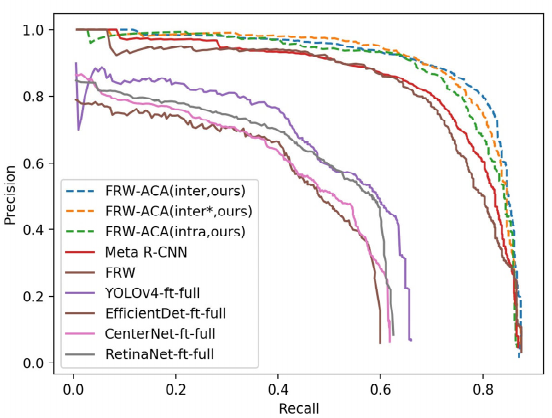
Figure 7. Precision–recall curves of our model and other baselines on the EAOD dataset. (* indicates remove spatial constraints in the mixture).